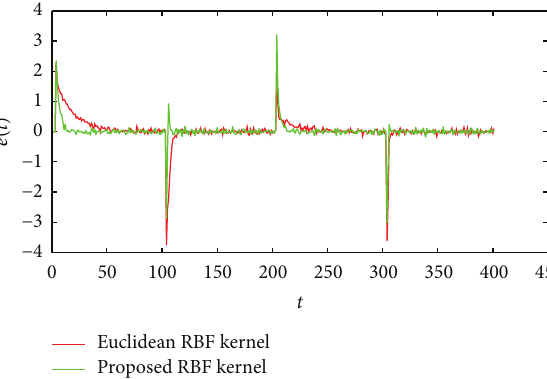
Figure 8: Comparing plant identification error for the two RBF kernels: Euclidean and proposed.